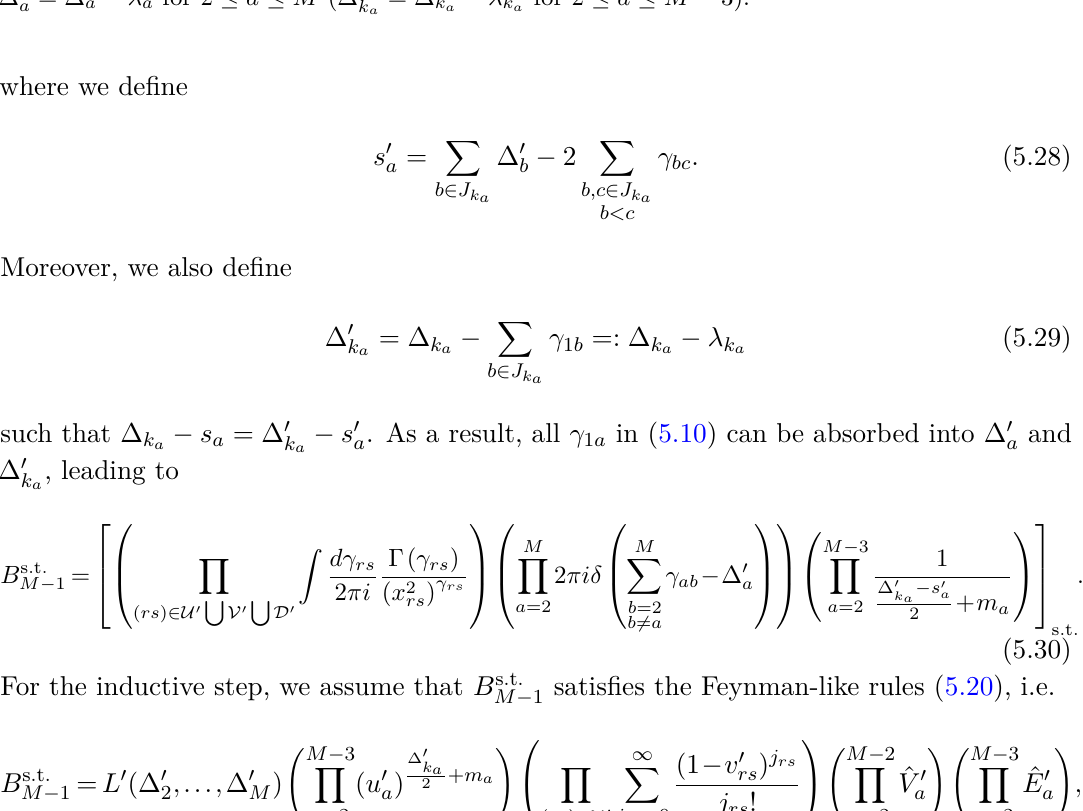
( ∆ ) and the ( M − 1) -point conformal block (left) a k a ( x ) ( O 0 ) have conformal dimensions a a k a = ∆ for 2 ≤ a ≤ M − 3 k a − λ k a k a